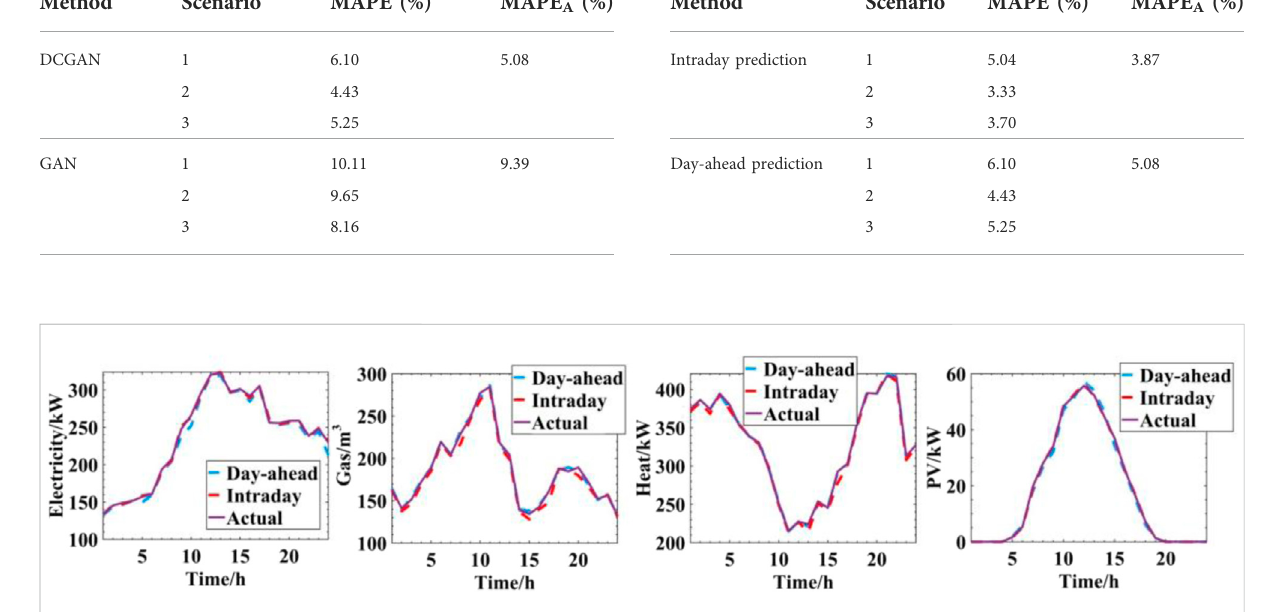
FIGURE 8 Comparisons of the day-ahead and intraday stages ’ retained scenario with the actual